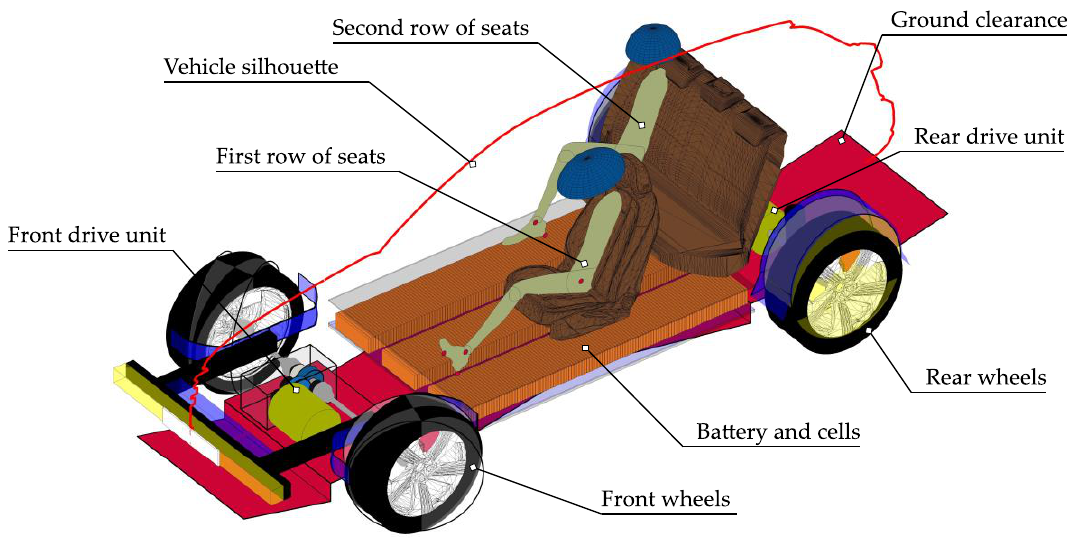
Figure 4. Typical output of the vehicle architecture tool, showing the calculated package layout and its components.